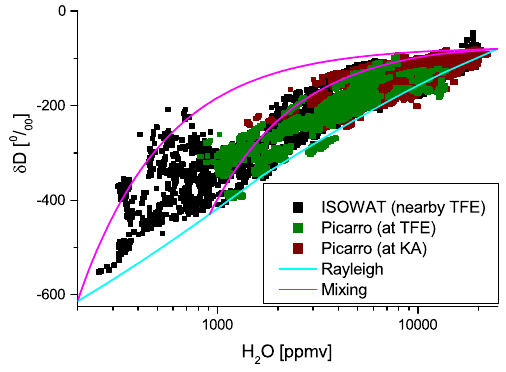
Figure 12. δ D–H 2 O plot using in situ observations made from different platforms (aircraft/ISOWAT and surface/Picarro) and at different sites (mid-latitudes at Karlsruhe, KA, and subtropics at Tenerife, TFE). Cyan line: Rayleigh curve for initialization with T = 25 ◦ C and RH = 80%. Magenta lines: two mixing lines. First for mixing between H 2 O[1] = 25000ppmv; δ D[1] =− 80‰ and H 2 O[2] = 900ppmv; δ D[2] =− 430‰. Second for mixing between H 2 O[1] = 25000ppmv; δ D[1] =− 80‰ and H 2 O[2] = 200ppmv; δ D[2] =−